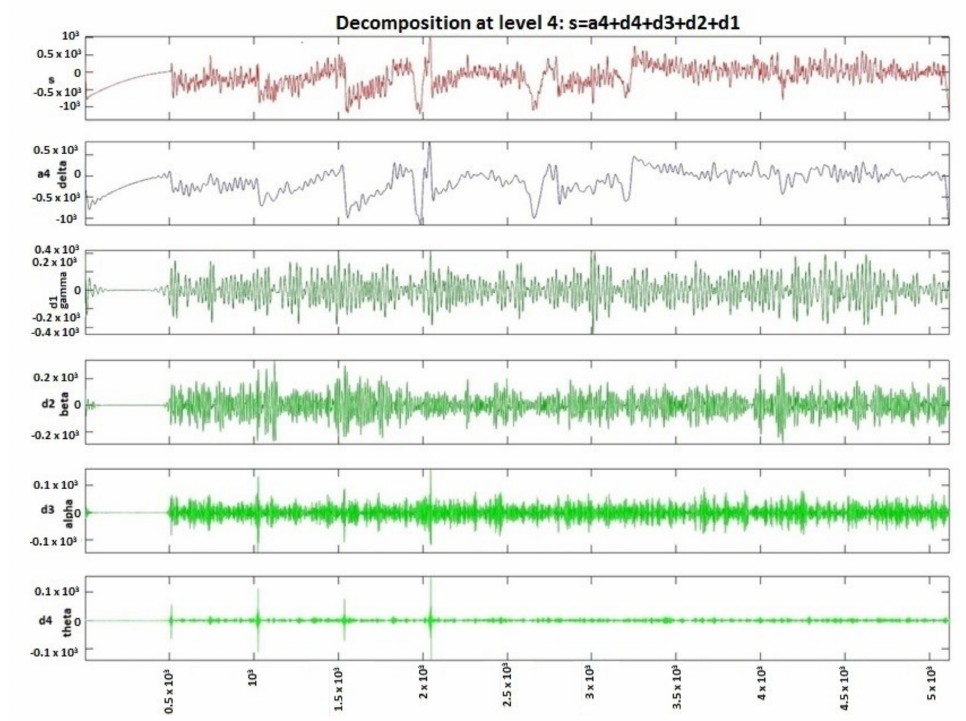
Figure 4. Patient with epileptic seizure, signal decomposition on four levels using